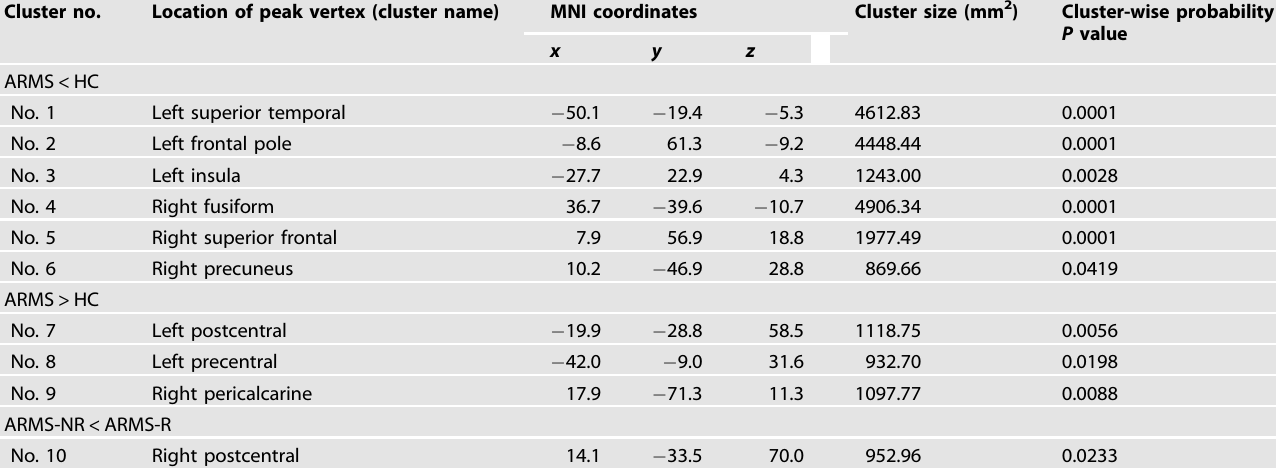
Table 2. Clusters with signi fi cant group differences in cortical thickness. Cluster no.